Question: Give a one-sentence summary of this figure.
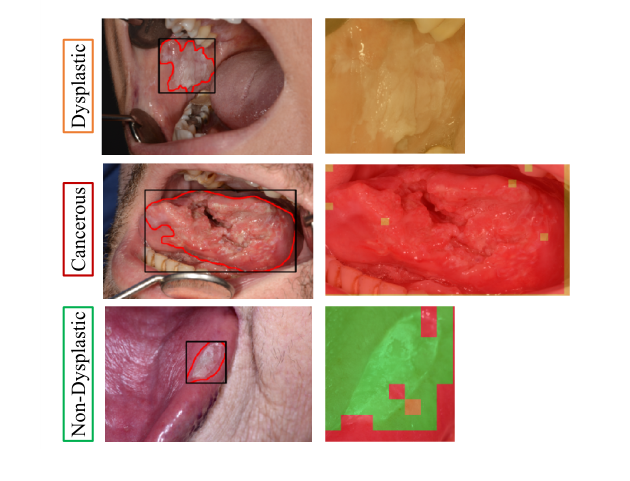
Answer: Top: F1-score for VGG-16, VGG-16 MIL, DenseNet and DenseNet MIL, where MIL is the network architecture shown in Fig. 1B. Bottom: Sample images classified by the VGG-16 MIL model.